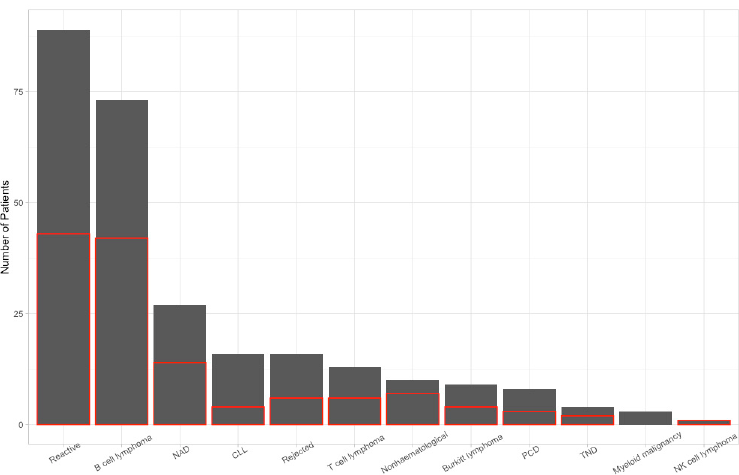
Figure 1. Bar plot representing the absolute number of patients with each fine needle aspiration flow cytometry (FNA FC) diagnosis (grey fill) and how many of these cases subsequently had a histological evaluation (red outline). NAD: no abnormalities detected; CLL: chronic lymphocytic leukemia; PCD: plasma cell dyscrasia; NK cell lymphoma: natural killer cell lymphoma; TND: test not done; Non-hematological: non-hematological malignancy; Reactive: reactive inflammatory infiltrate.